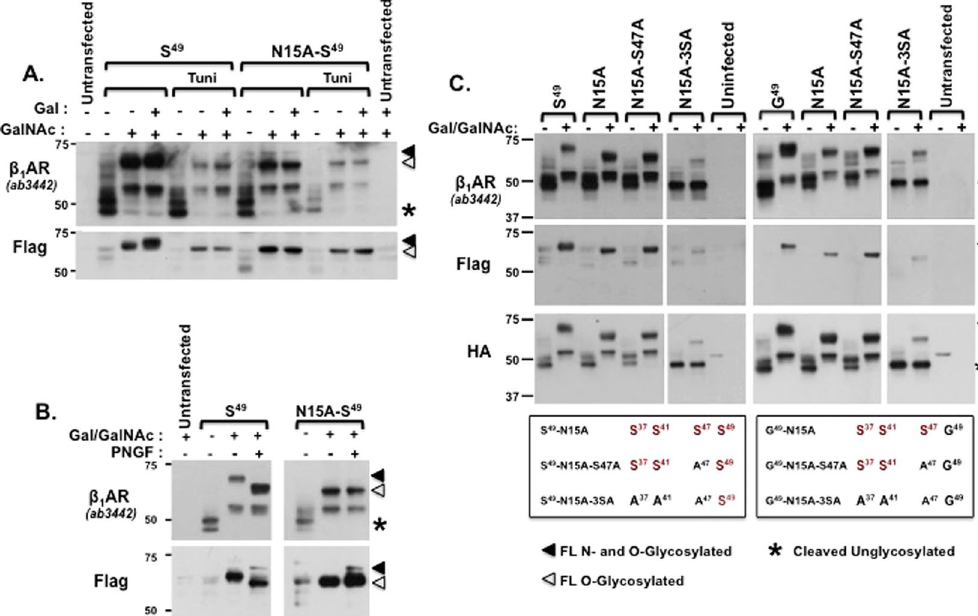
Figure 3. Mutagenesis studies to map β 1 AR N-terminal glycosylation sites. ldlD cells transfected with wild type or single residue substituted forms of the β 1 AR were cultured without or with Gal (20 μ M) and GalNAc (200 μ M) as indicated. Tunicamycin (Tuni) was added to the culture medium (1 μ g/ml for 24 hr) to block N-glycosylation in Panel A . Samples were incubated with PNGase F (PNGF 2 U/mL, 16 hr) to hydrolyze N-linked sugars in Panel B . Lysates were subjected to immunoblot analysis with an anti- β 1 AR antibody (raised against a β 1 AR C-tail epitope) or antibodies to Flag and HA epitope tags at the N- and C-termini, respectively. Positions of the full-length fully N- and O-glycosylated β 1 AR (filled triangle), the full-length O-glycosylated receptor (that lacks the N 15 -linked glycan, open triangle) and the N-terminally-cleaved unglycosylated receptors (asterisk) are